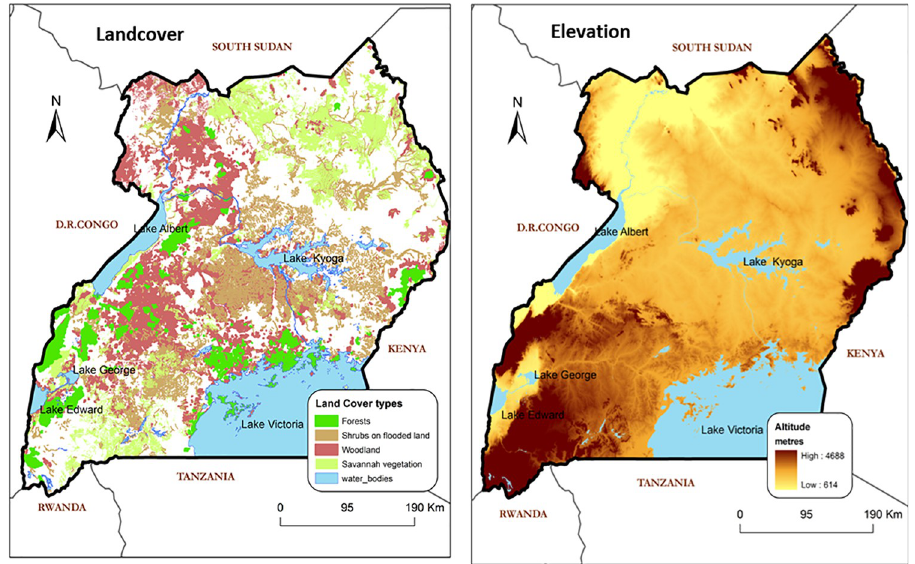
colour tables. Coordinate System Description: Geographic; Units: DD (decimal degrees), Spheroid: WGS84.